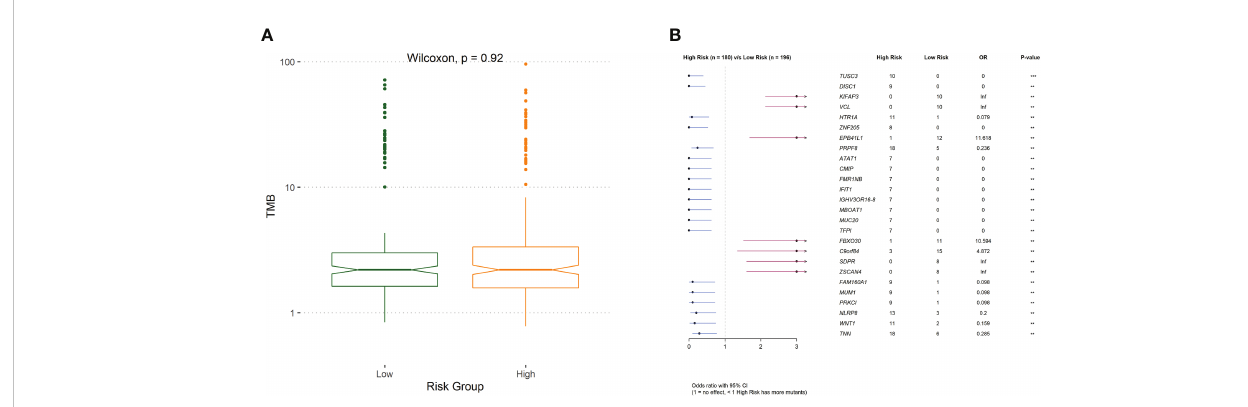
FIGURE 8 (A) The difference of tumor mutation burden between low- and high-risk group. (B) Comparison of risk for differentially mutated